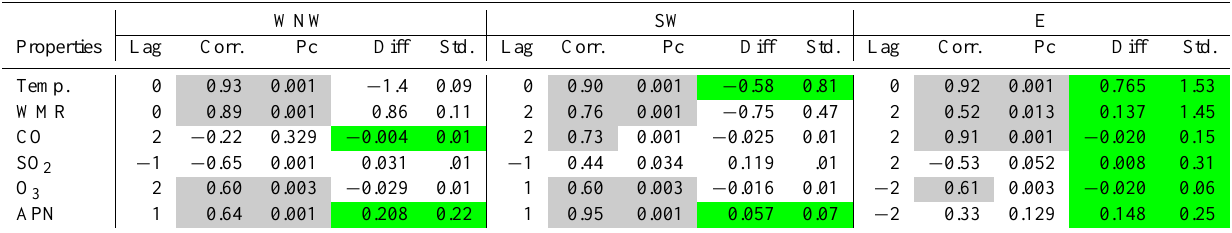
Table 3. Statistical parameter